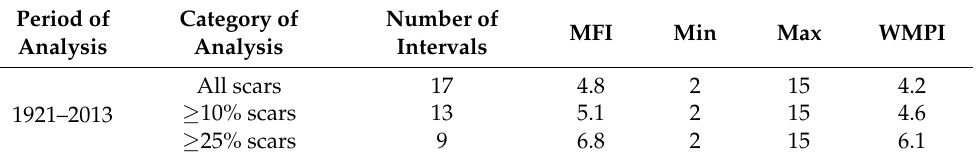
Table 1. Fire interval descriptive statistics for an Abies religiosa forest.